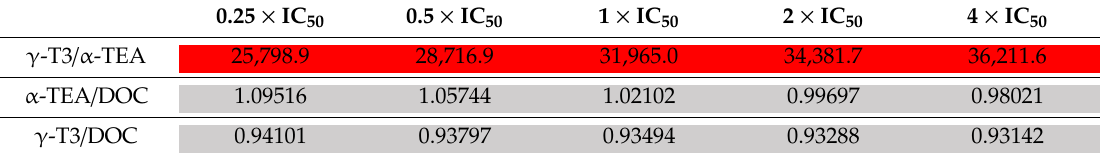
Table 1. Chou-Talalay combination index (CI) chart for dual combinations of γ -T3, α -TEA, and